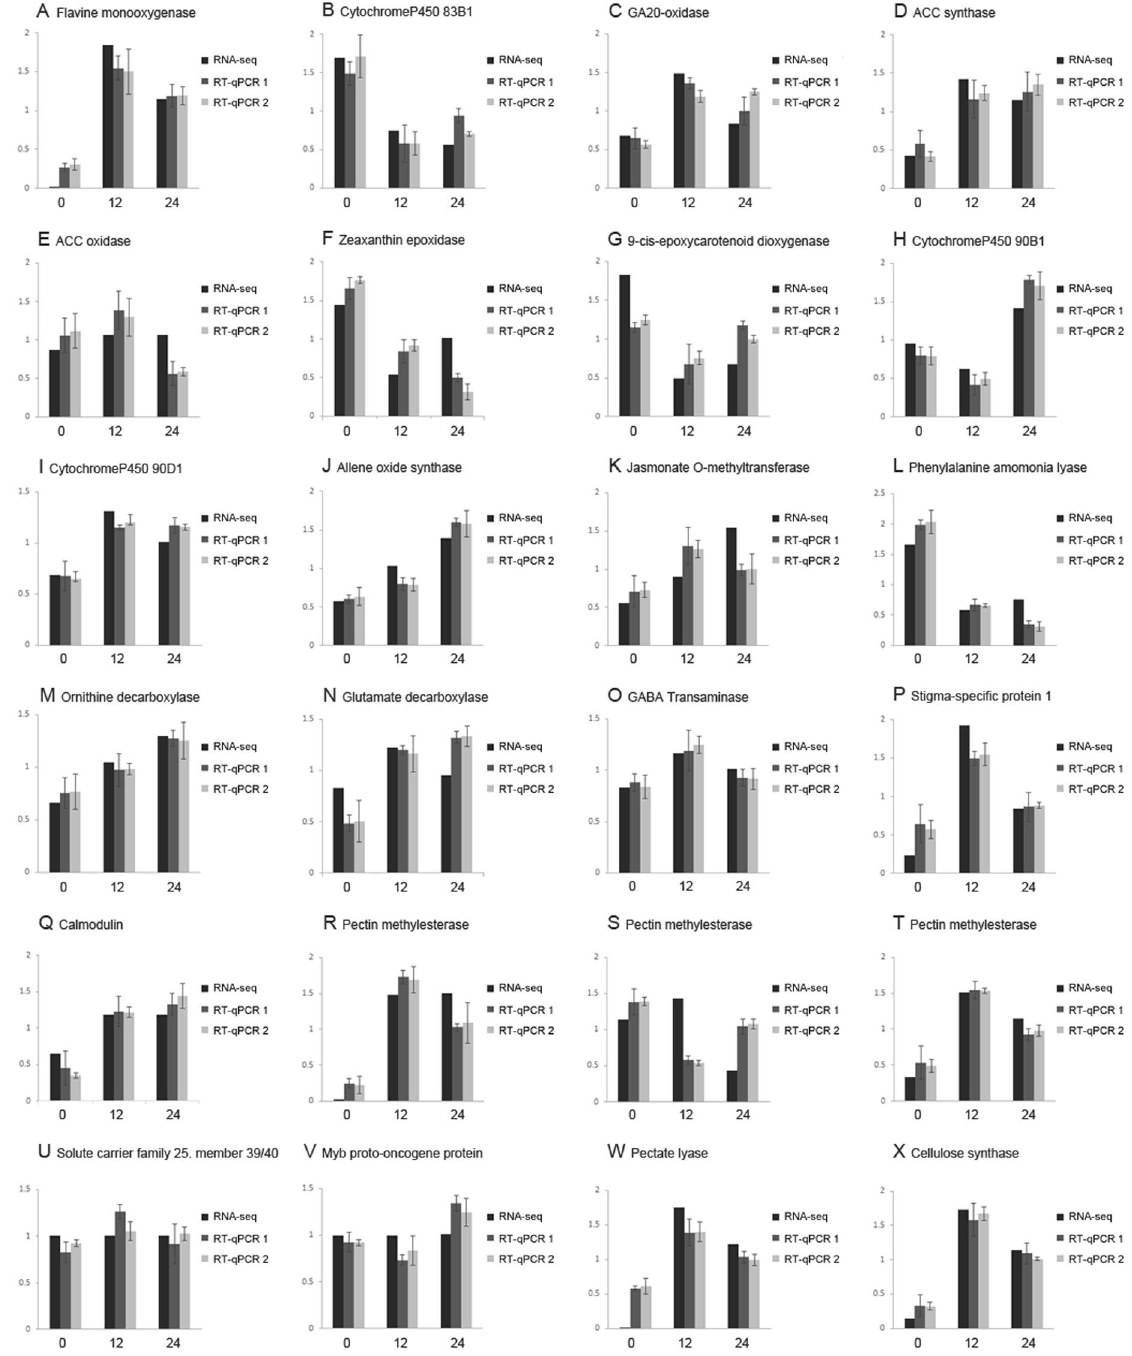
Figure 4. Comparison of transcript abundance determined by RNA-seq and RT-qPCR in 0, 12, 24 h samples. RNA-seq, results of transcript abundance determined by RNA-seq are shown with a black colar. RT-qPCR 1, results of transcript abundance determined by RT-qPCR using Actin gene as reference gene are shown with a gray colar, and RT-qPCR 2, results of transcript abundance determined by RT-qPCR using Ubiquitin gene as reference gene are shown with a lighter gray